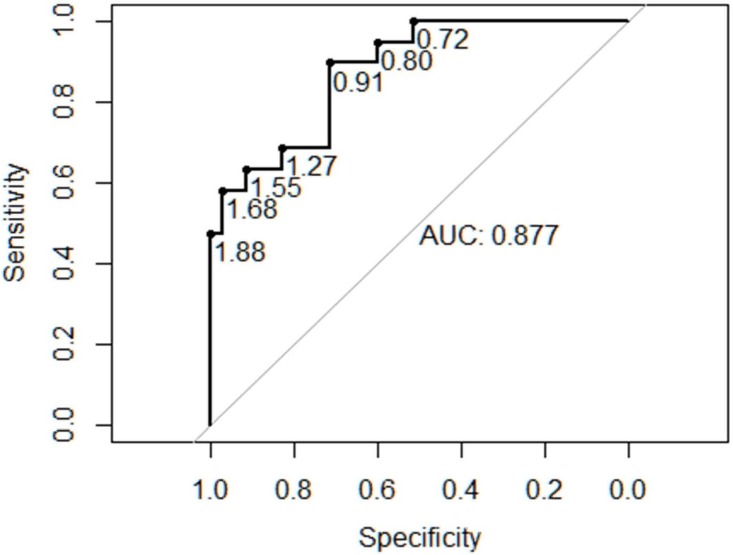
Receiver operator characteristics curve for the congenital pulmonary airway malformation-volume ratio (CVR) and composite adverse outcome or need for intervention.